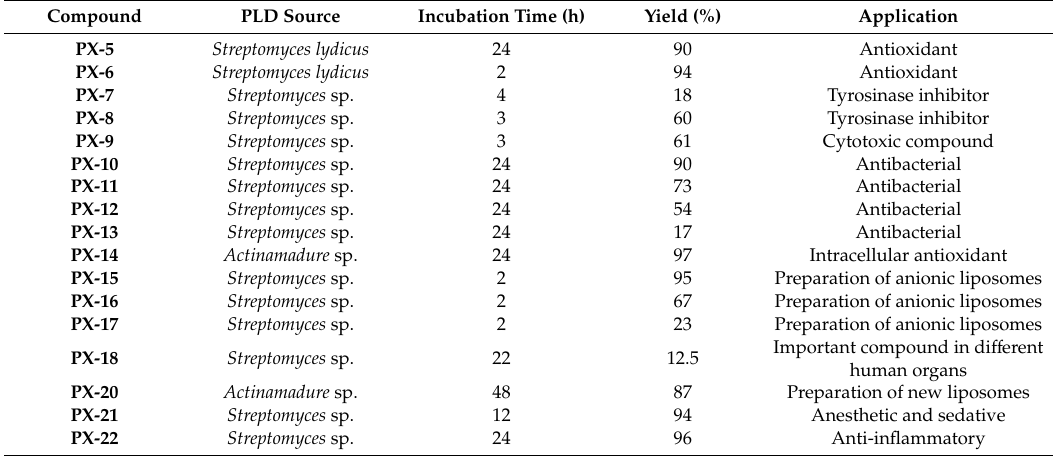
Table 1. Synthetic phospholipids (PLs) with essential preparation parameters (PLD source, incubation time, yield) and their main applications.